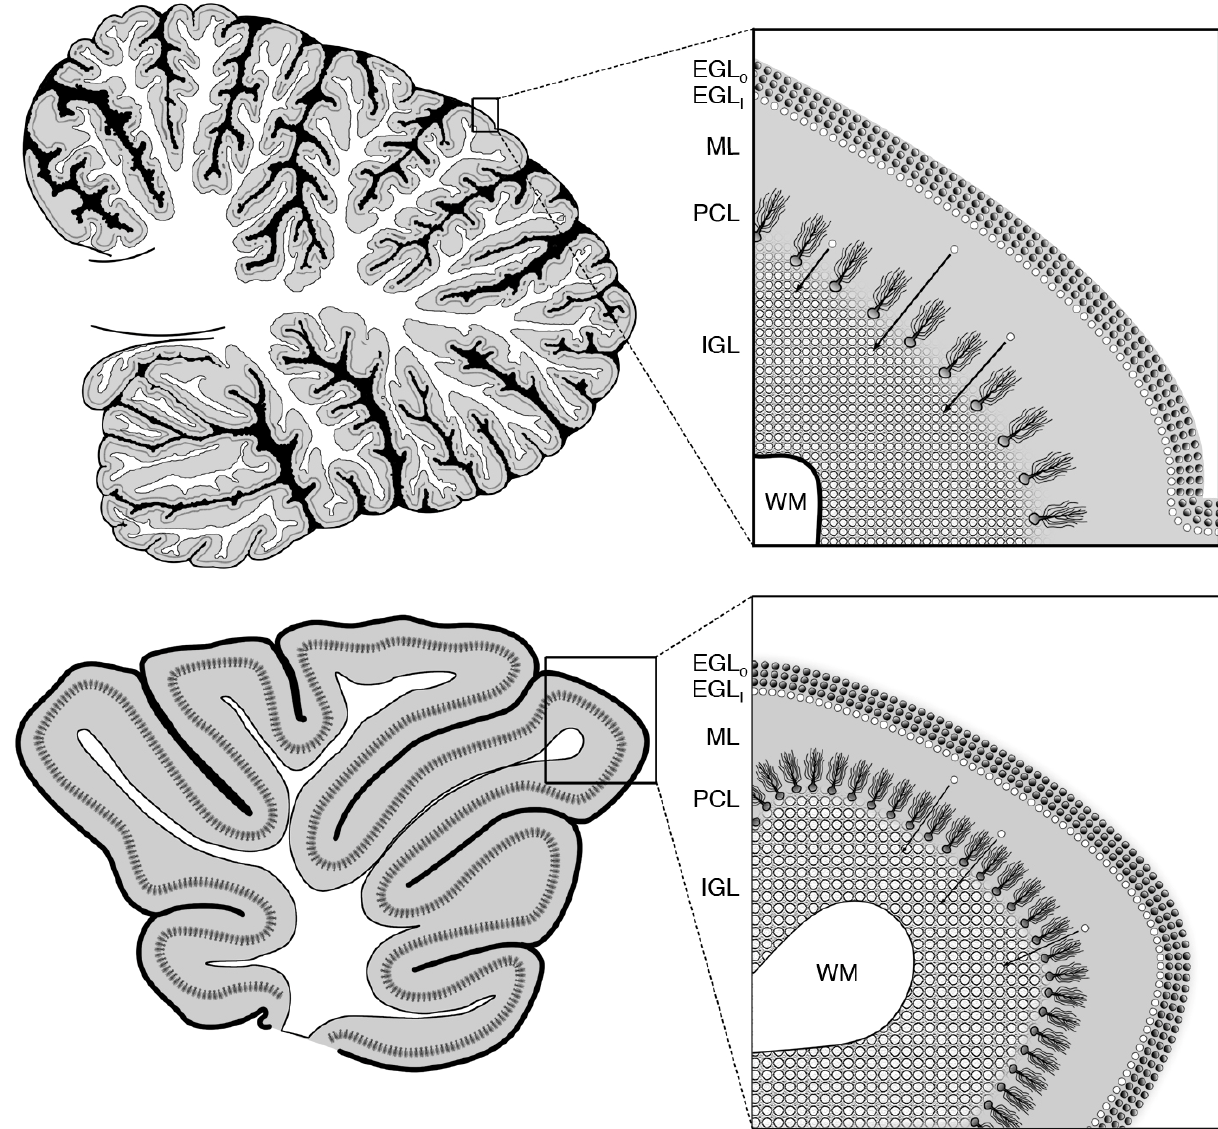
Figure 2. Midsaggittal diagram of the human and rodent cerebellum and its constituent layers during perinatal development. The gyrencephalic nature of human cerebellum (TOP) leads to more gyri and sulci than the more lissencephalic rodent cerebellum (BOTTOM). Despite these differences, the human and rodent cerebella maintain the same basic cortical cytoarchitecture. In both species, the outermost layer of the cerebellum is the transient external granule layer (EGL), which is composed of an outer germinal matrix populated by neural progenitor cells (EGL ; dark spheres) and an inner layer (EGL ; white spheres) O I where newly formed granule cell neurons congregate and mature. After a short time, these granule cells then migrate (white spheres with arrows) past the molecular (ML) and Purkinje cell layers (PCL) before becoming incorporated into the internal granule layer (IGL), which lies superficial to the cerebellar white matter (WM). After birth, the EGL begins to disappear as its job of producing new neurons ends, and the cerebellum transitions into a more adult state. Insets (right) reflect magnified views of boxed regions